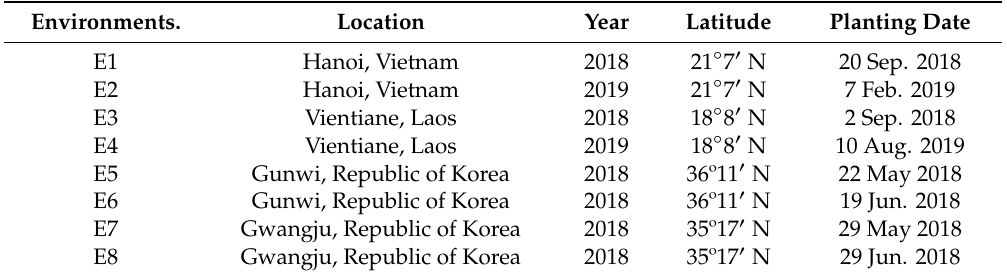
Table 2. Planting locations, years, latitude, and planting dates at each of four locations over two years. Environments. Location